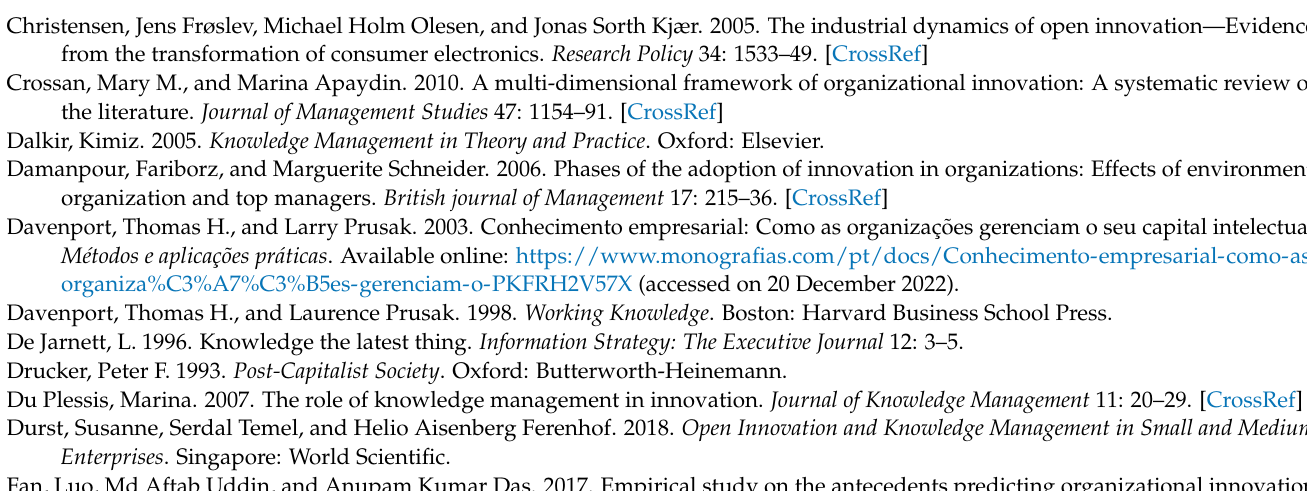
Figueiredo, Ronnie, and Bouchaib Bahli. 2021. Service Business Growth: A Spinner Innovation Model Approach. In Technological Figueiredo, Ronni é , and Jo ã o Jos é de Matos Ferreira. 2020. Spinner model: Prediction of propensity to innovate based on